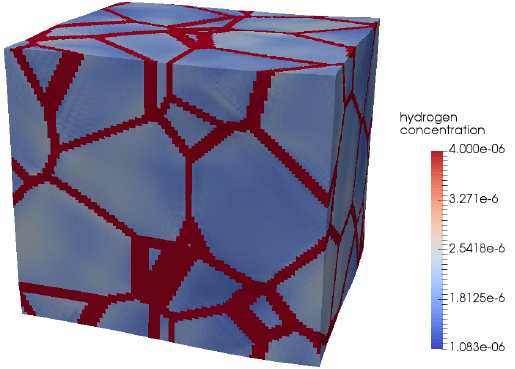
Figure 7. Simulation of a polycrystal containing dislocations with a binding energy to grain boundaries and a voxel size of L voxel = 1 µ